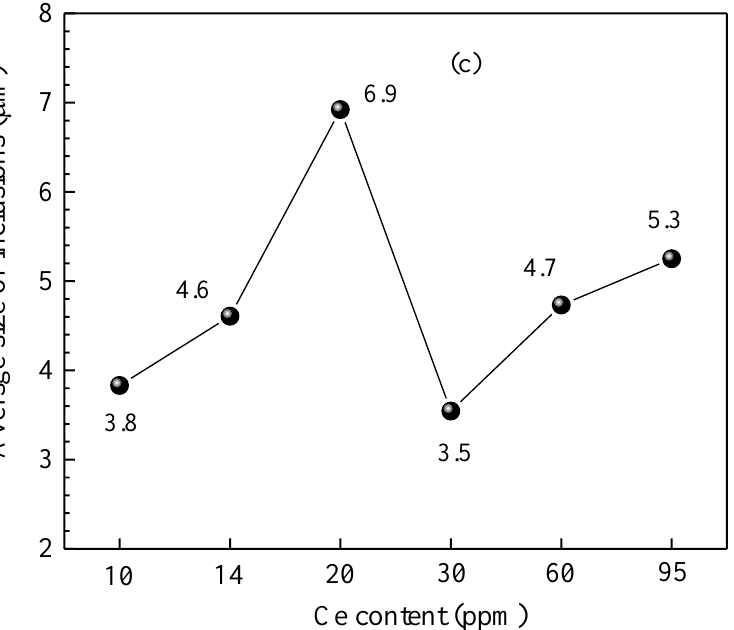
Figure 15. Size distribution and average size of inclusions in the steel of different heats. ( a ) Inclusion size distribution, ( b ) ratio of different size inclusions, ( c ) average size of inclusions.